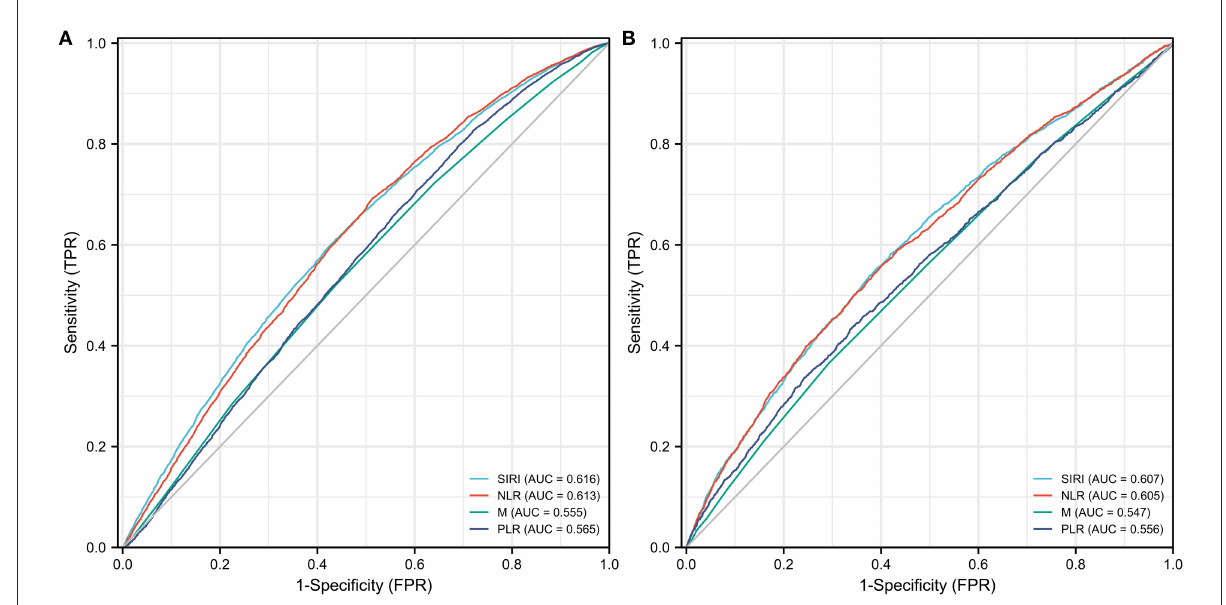
FIGURE4 Comparison for the predictive ability of SIRI and traditional inflammatory biomarkers for all-cause mortality (A) and CVD mortality (B)